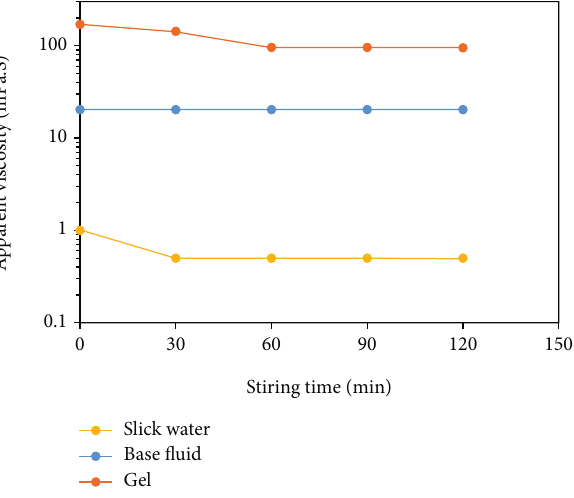
Figure 4: Rheological parameters of di ff erent fracturing fl